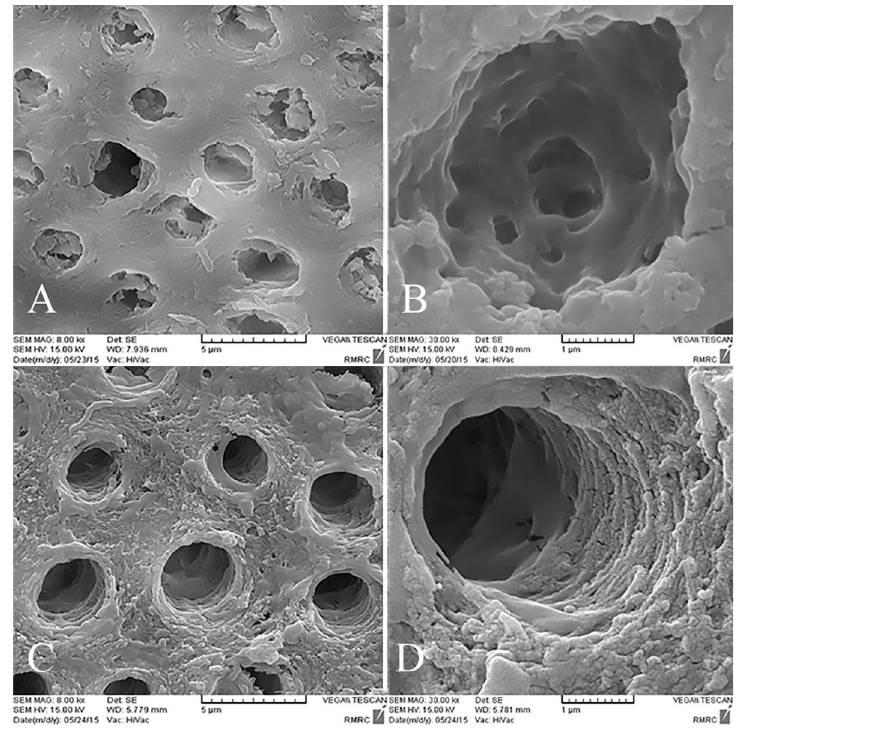
Fig 4. SEM images of the GSE group. A,B. Before acidic challenge. C,D. After Acidic challenge.